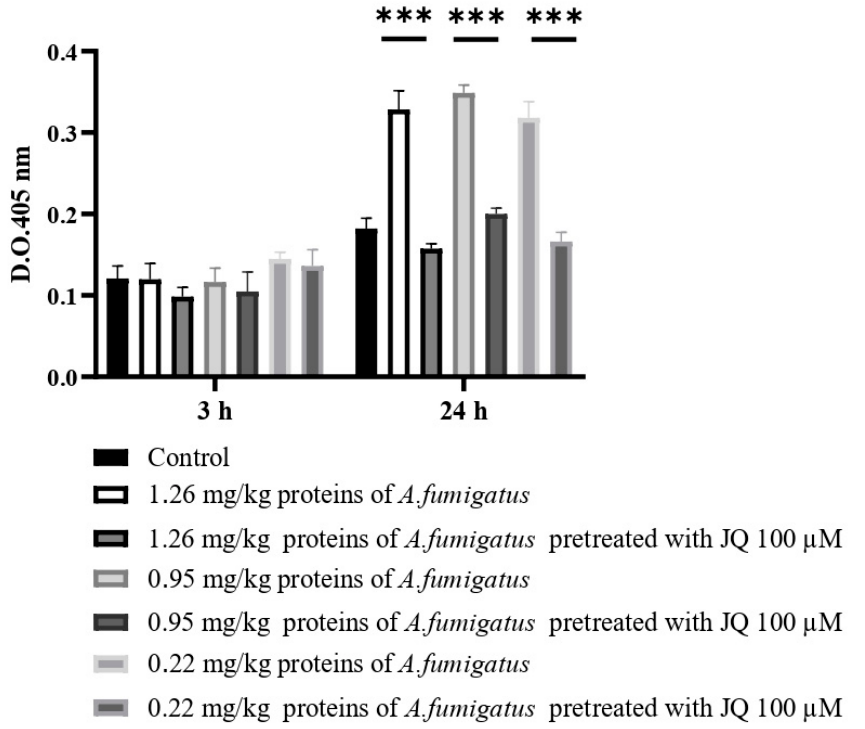
Figure 11. The melanization of larvae hemolymph after the injection of different concentrations of proteins from A. fumigatus and JQ1. At least three independent experiments were performed. Unpaired Student t -tests to statistical analysis were performed. *** p < 0.001 compared to the conidia from A. fumigatus .